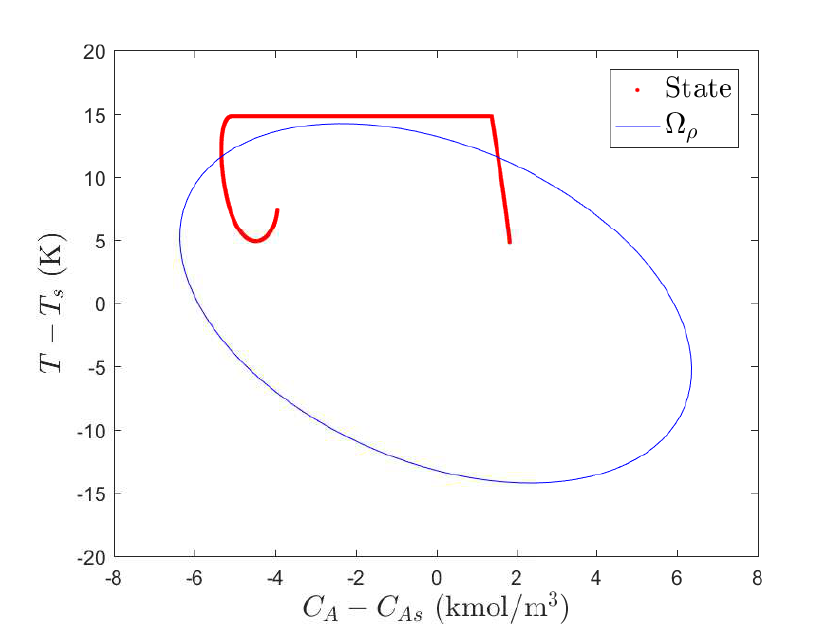
Figure 10. State-space plot when a cyberattack is performed for the methyl isocyanate hydrolysis process. Data was plotted every 1000 integration steps (i.e., every 10 − 3